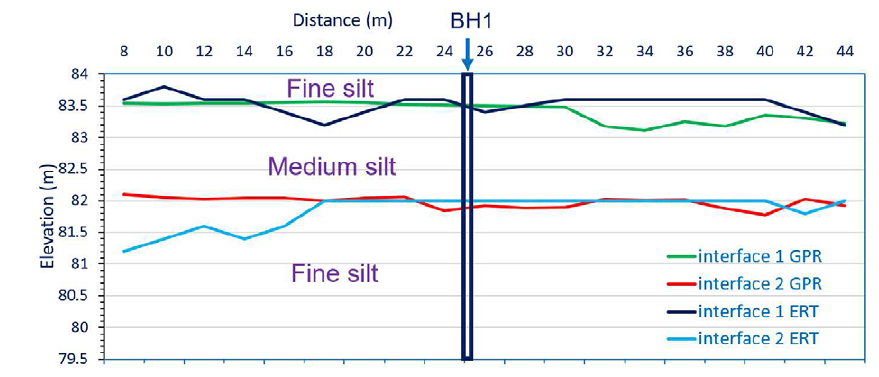
Figure 8. The longitudinal change of structural interfaces along the investigated levee section based on 200 MHz GPR